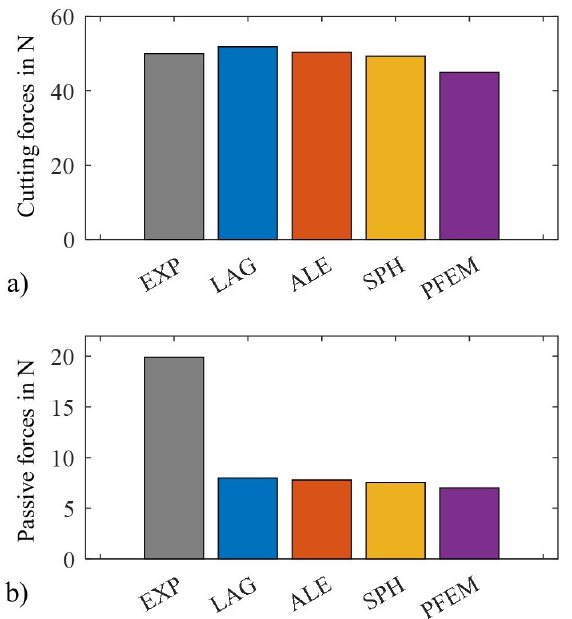
Figure 7. Comparison of the cutting forces ( a ) and passive forces ( b ) of the discretizational approaches with the experimental results from [32] for the 2D orthogonal cutting model γ = 20 ◦